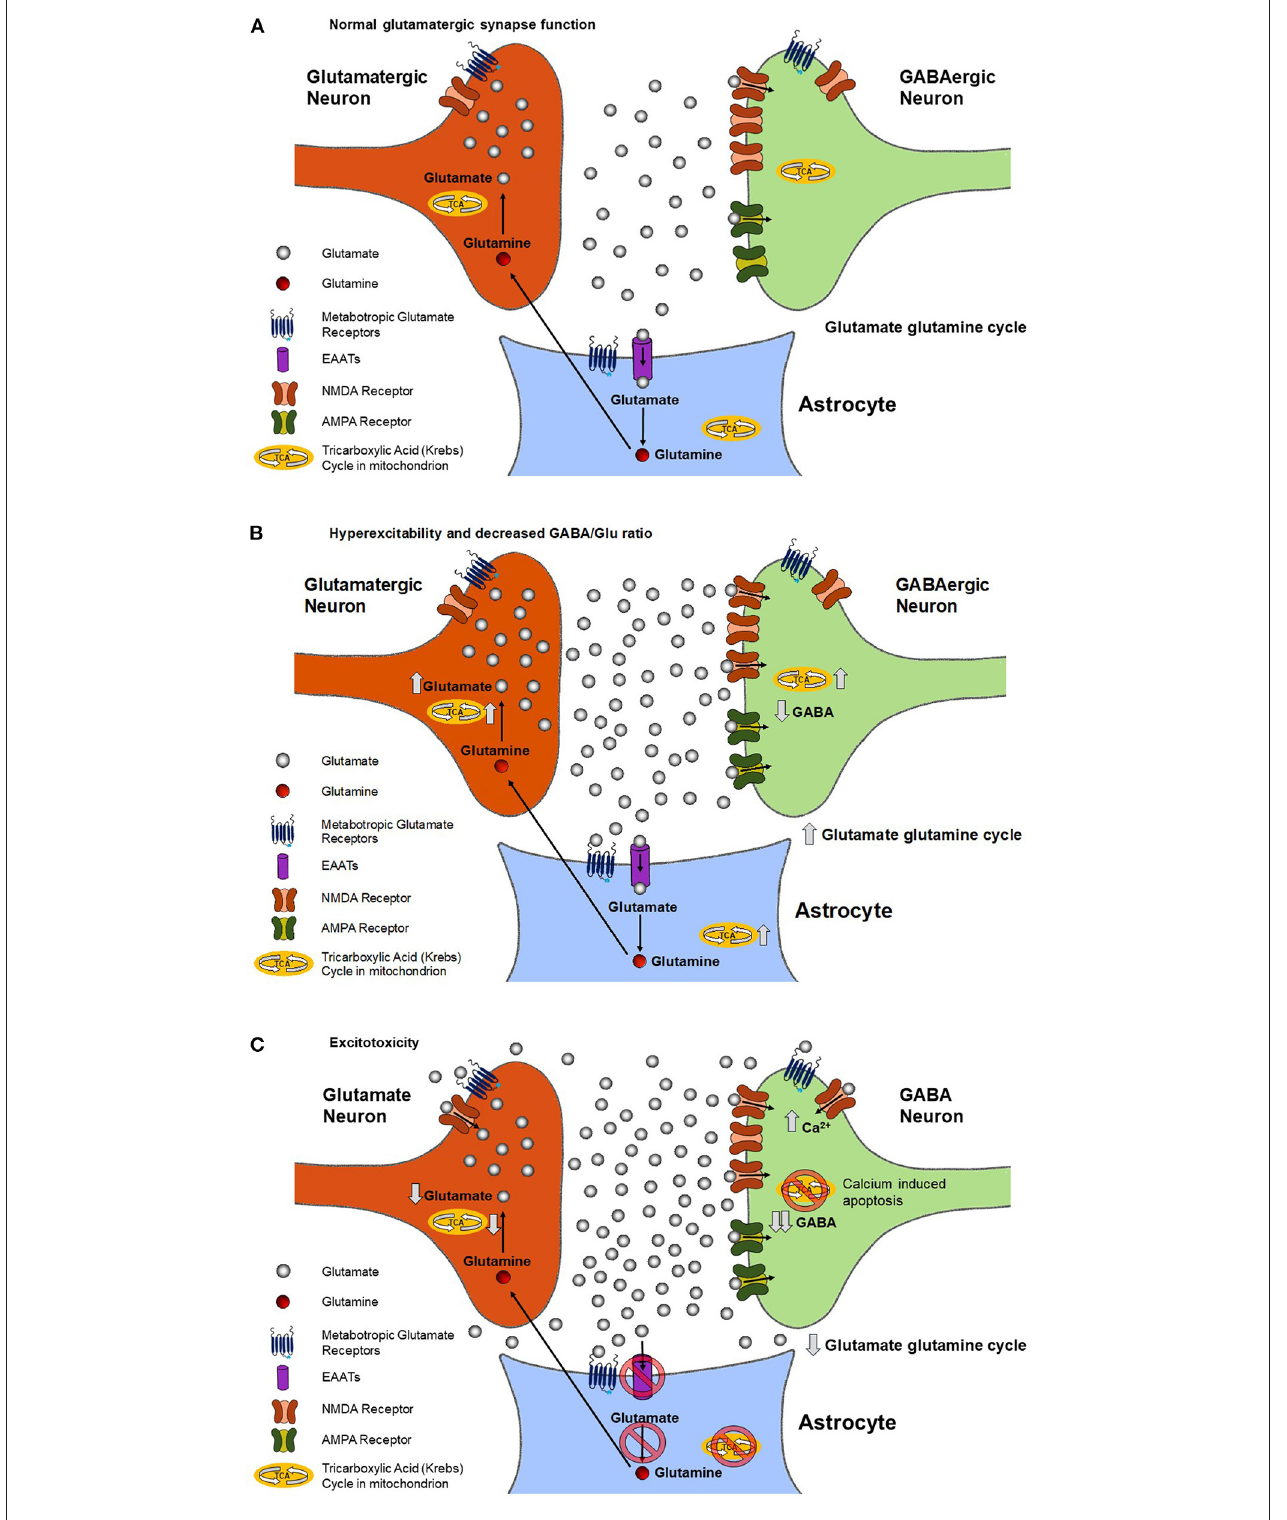
FIGURE 1 | Predicted changes in the rate of mitochondrial ATP production, the rate of the glutamate/glutamine neurotransmitter cycle, and extracellular and intracellular glutamate and GABA concentrations during the progression of ALS in a glutamatergic synapse. During normal neuronal signaling (A) ,